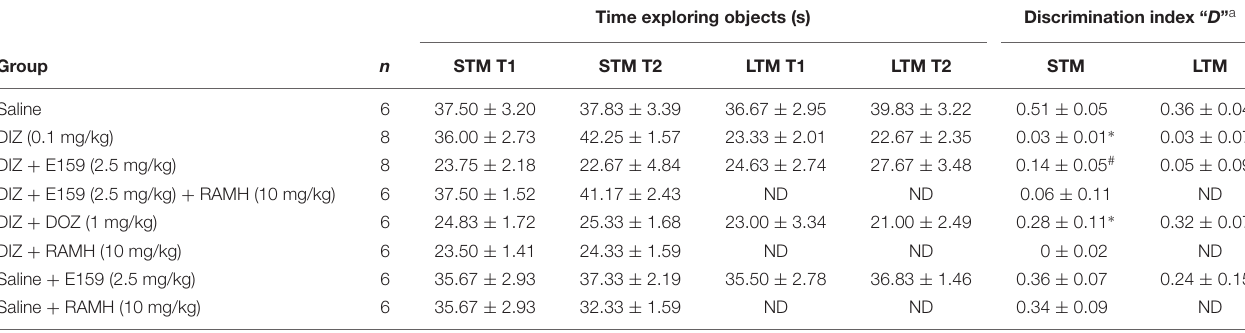
TABLE 1 | Effects of E159 on DIZ-induced total amount of time spent exploring both objects during object recognition training and test session in rats. Time exploring objects (s) Discrimination index “ D ”